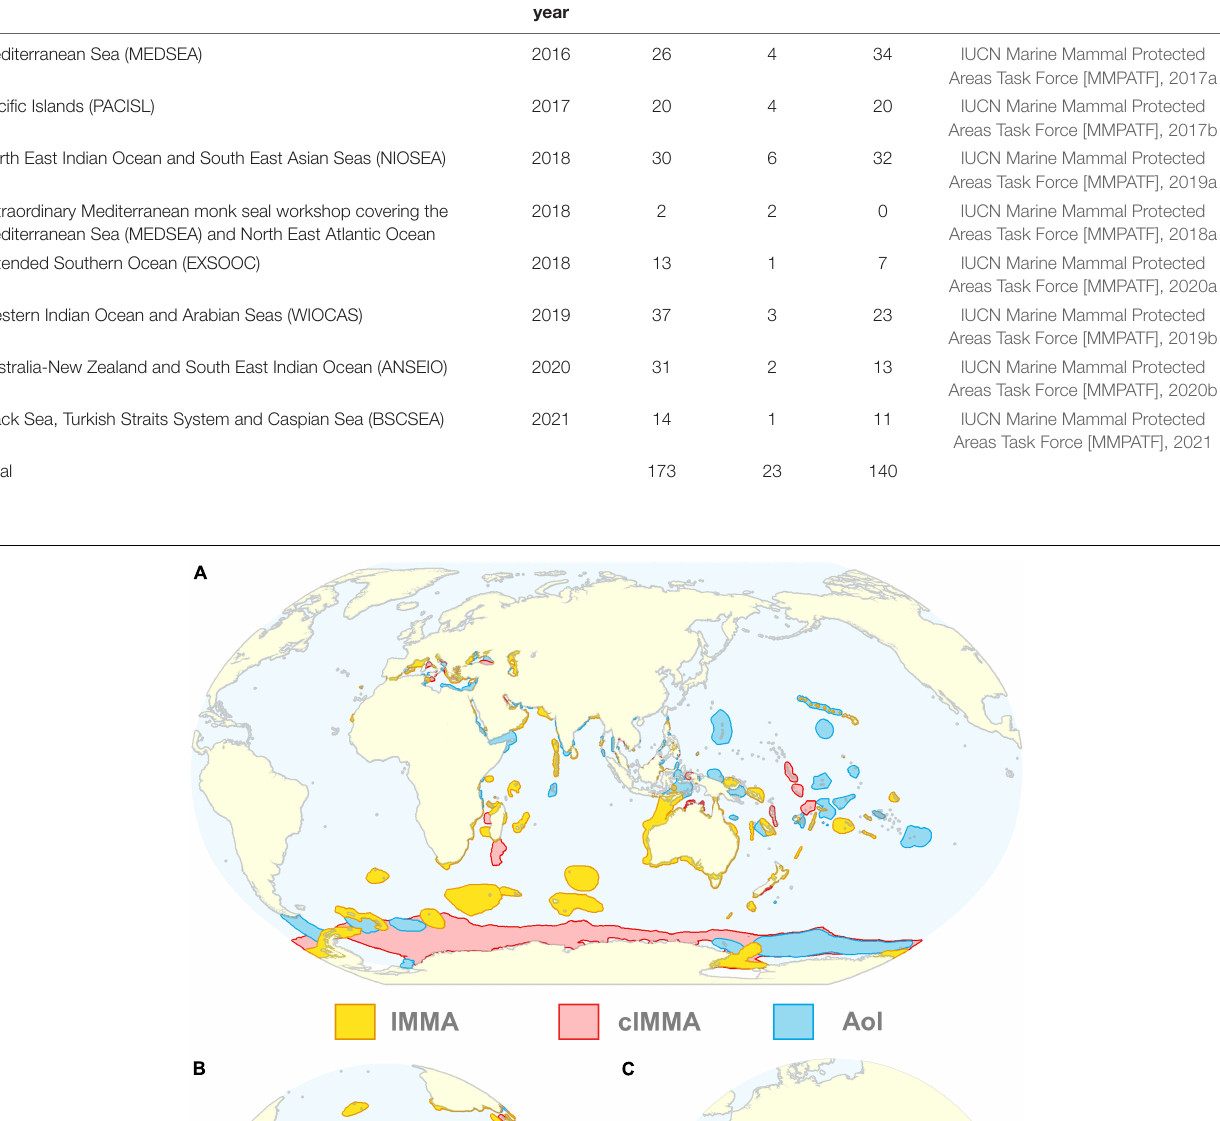
TABLE 1 | Summary of the number of IMMAs, cIMMAs and AoI by workshop region across the IMMA Network ( n = 336). Region IMMA cIMMA AoI